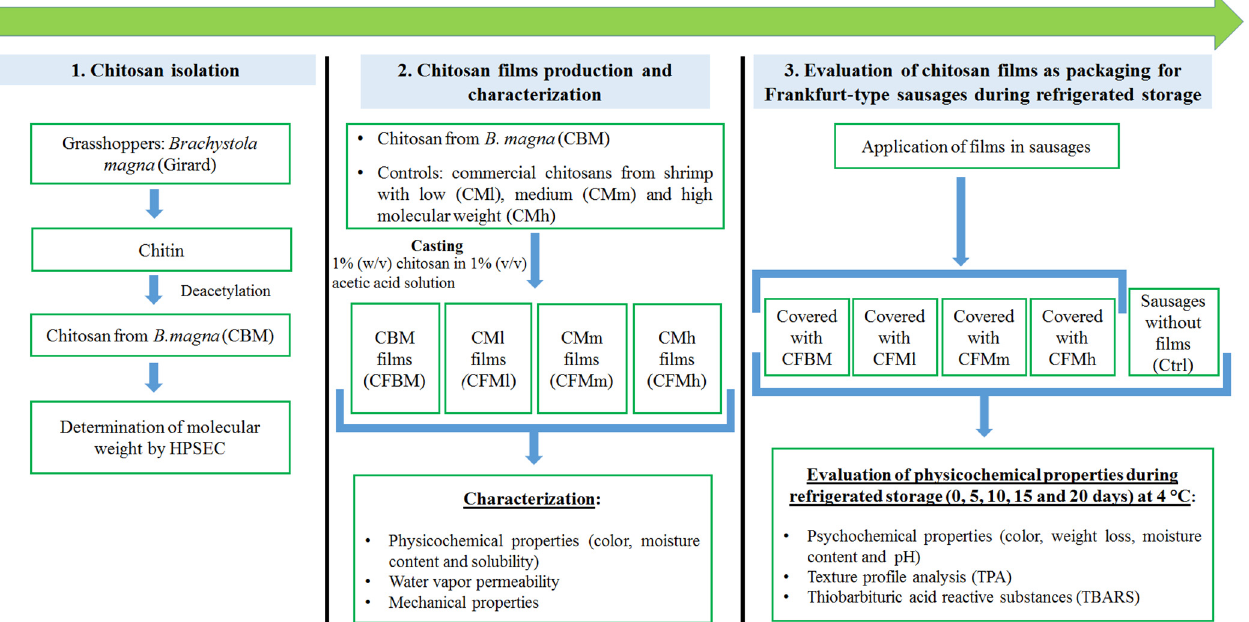
Figure 3. Description of the general methodoloy.